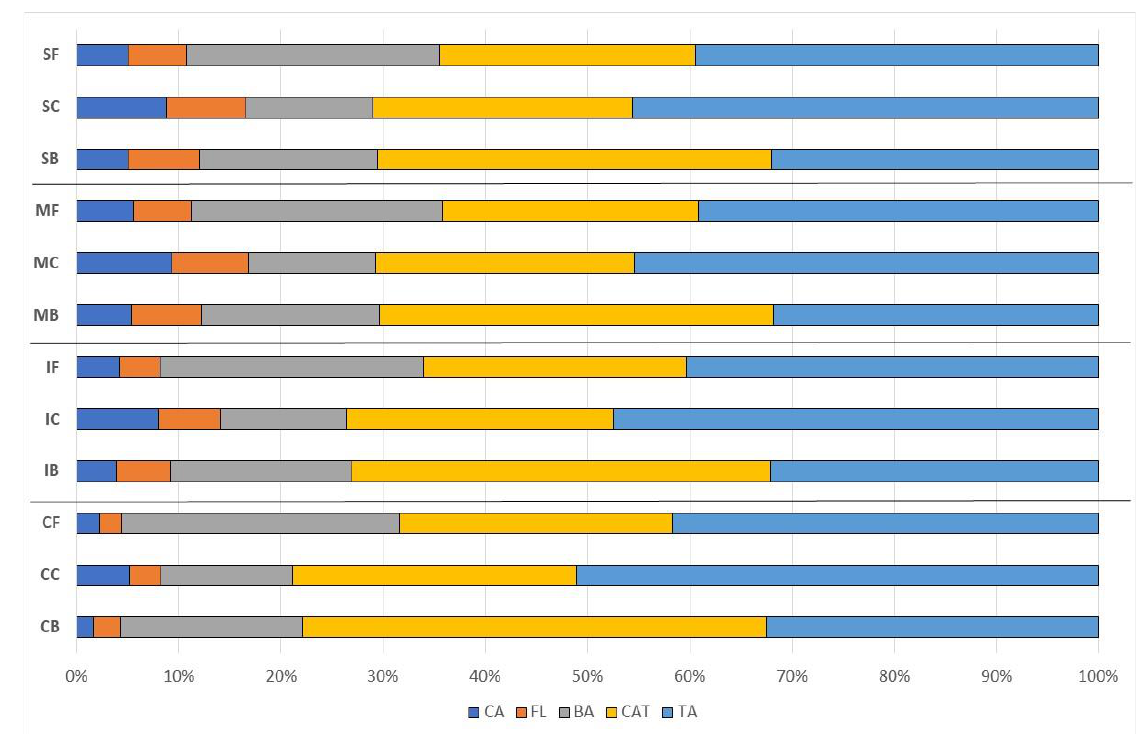
Figure 3. Phenolic phytocomplex of the analysed chestnut groups. Different colours define each